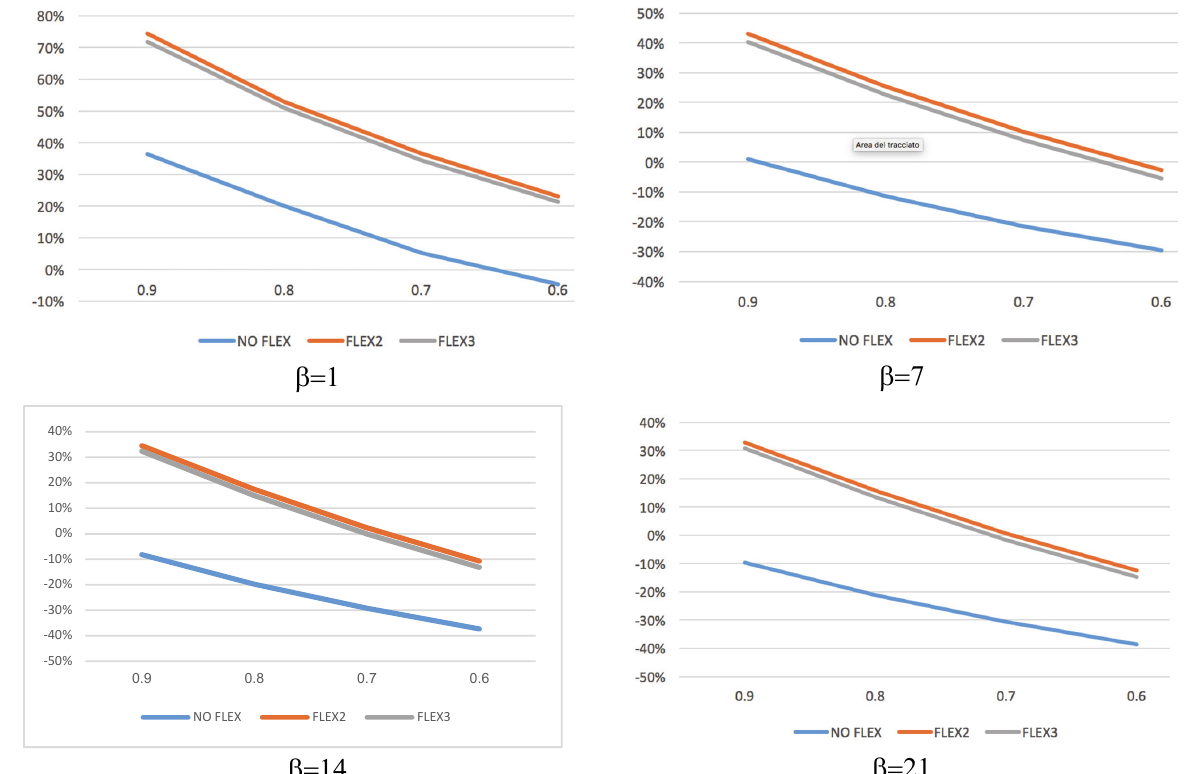
Fig. 3. Simulation results - EXPO